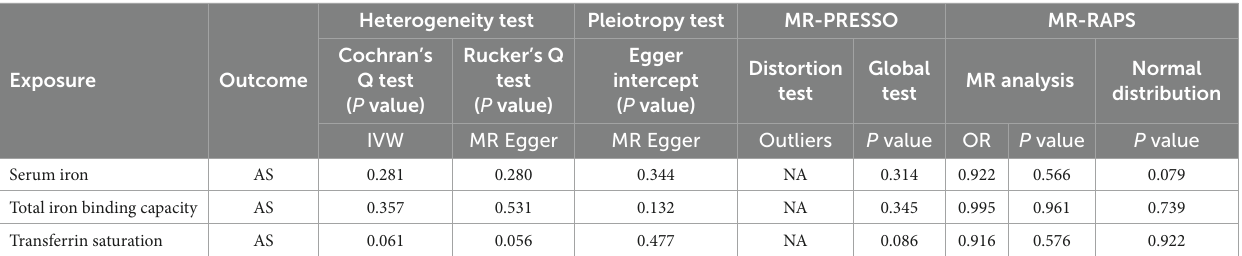
TABLE 3 Sensitivity analysis of the MR analysis results of exposures and outcomes after exclusion of outlier SNPs detected by MR-PRESSO.